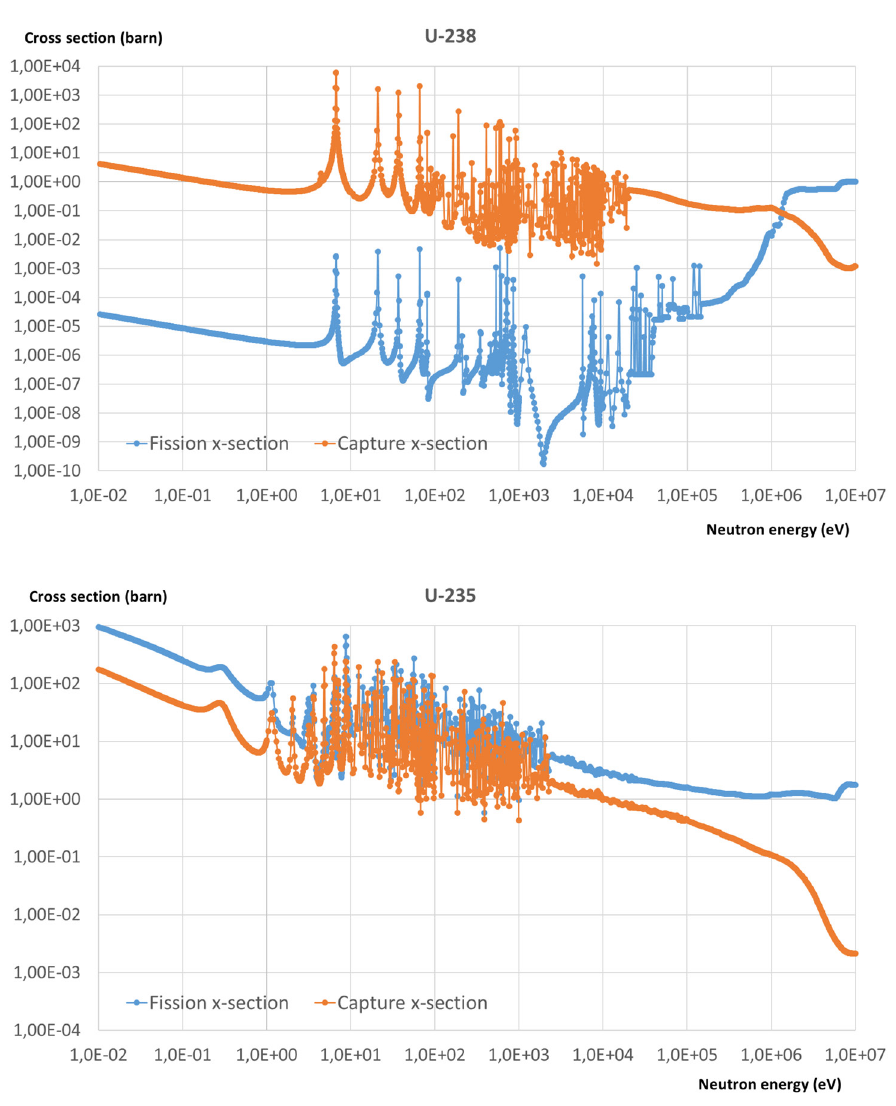
Fig. 3. – Fission (blue) and radiative capture (red) cross sections for the two isotopes of uranium.